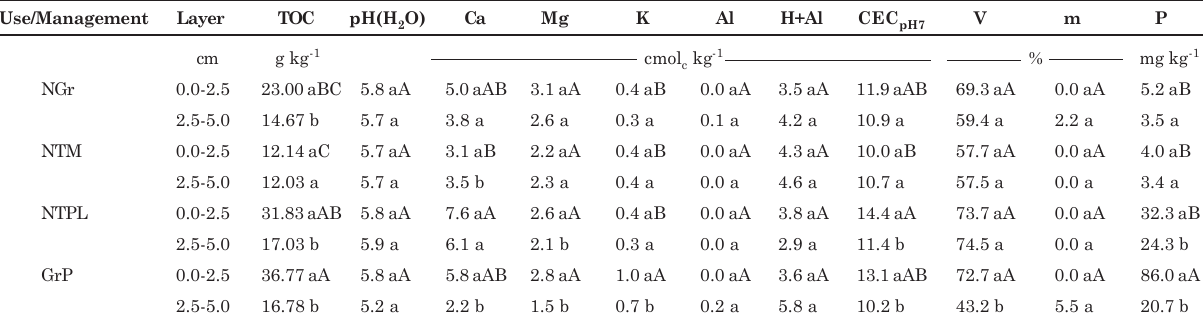
Table 2. Chemical properties of the sorption complex of two layers of a Rhodic Paleudult under four land use and management